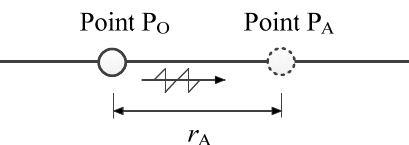
spectra of the accelerations on a log-log scale.